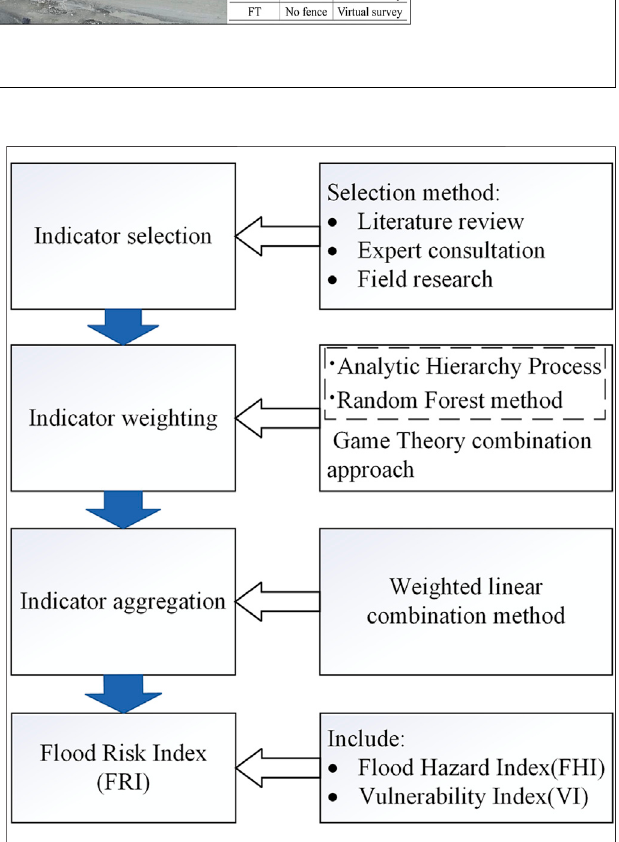
FIGURE 4 | The process of indicator-based fl ood risk